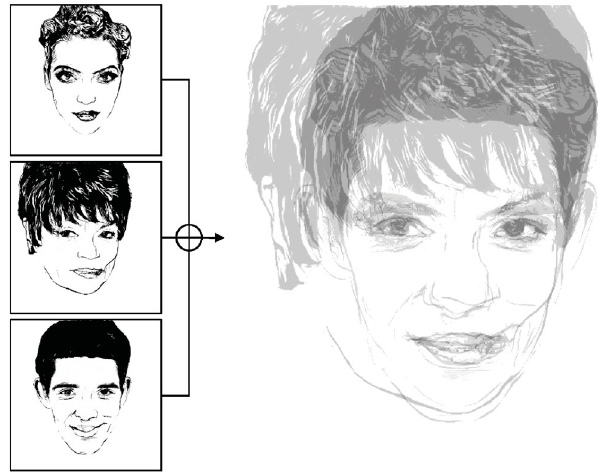
Fig. 7 A limitation of ShadowDraw: the blended image (right) has difficulty preserving details of facial images